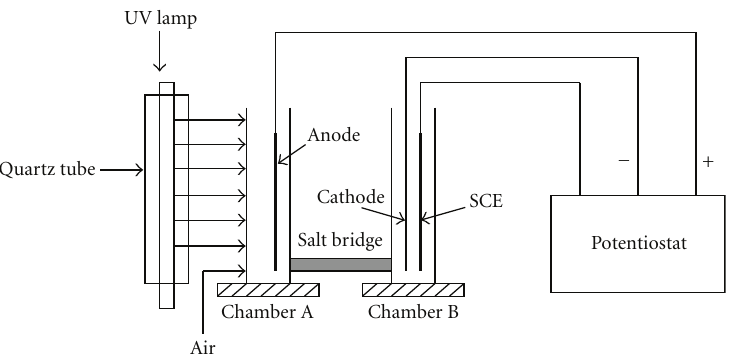
Figure 1: Schematic diagram of PC and PEC photoreactor